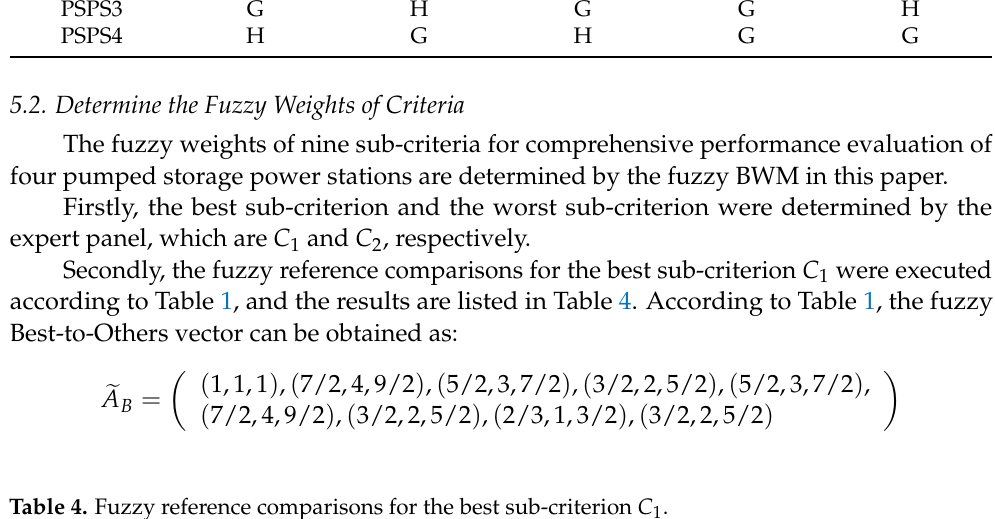
Table 4. Fuzzy reference comparisons for the best sub-criterion C 1 . Best